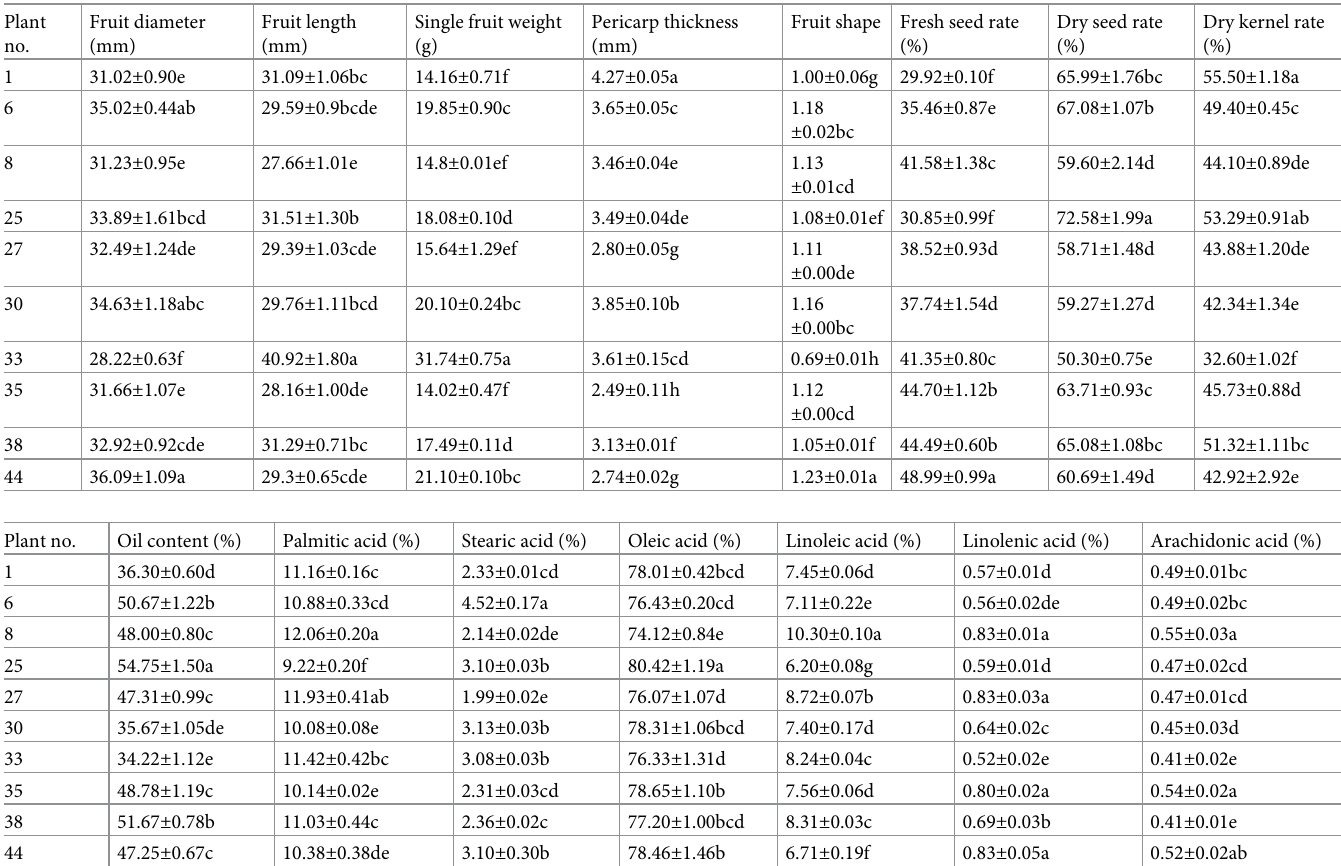
Table 5. Detailed economic characteristics of the fruit of the nine superior C . weiningensis plants. Plant